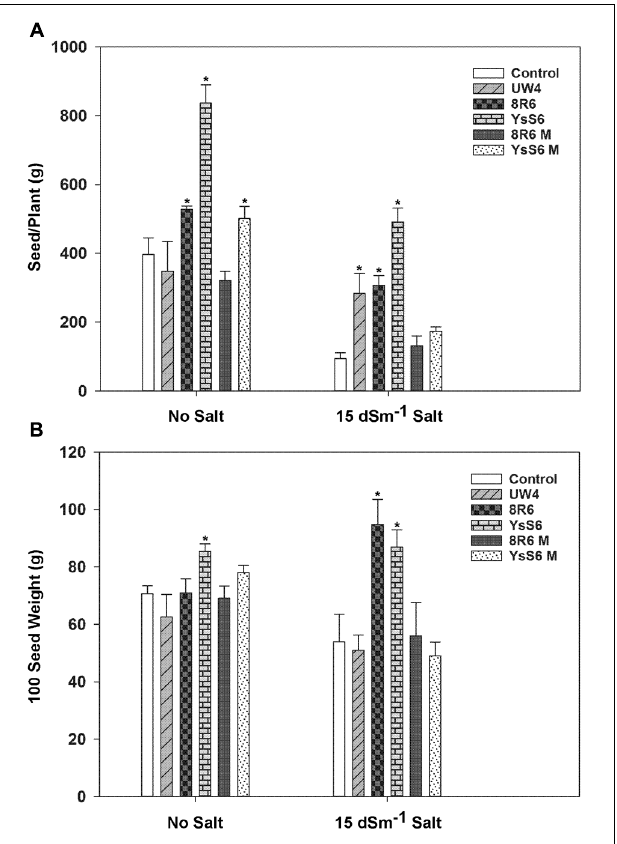
FIGURE 3 | The effect of soil inoculation with PGPB on seed production of camelina plants grown in the absence, or presence of, salt (15 dSm − 1 ). (A) Shows the amount of seeds produced per plant and (B) the weight of 100 seeds. Error bars indicate standard error ( n = 25 plants in control and 10 plants under moderate salt stress). A two- way ANOVA and Tukey post-test were used to detect significant differences between groups. Asterisks ( ∗ ) above bars indicate values that are significantly different ( p < 0.05) from the